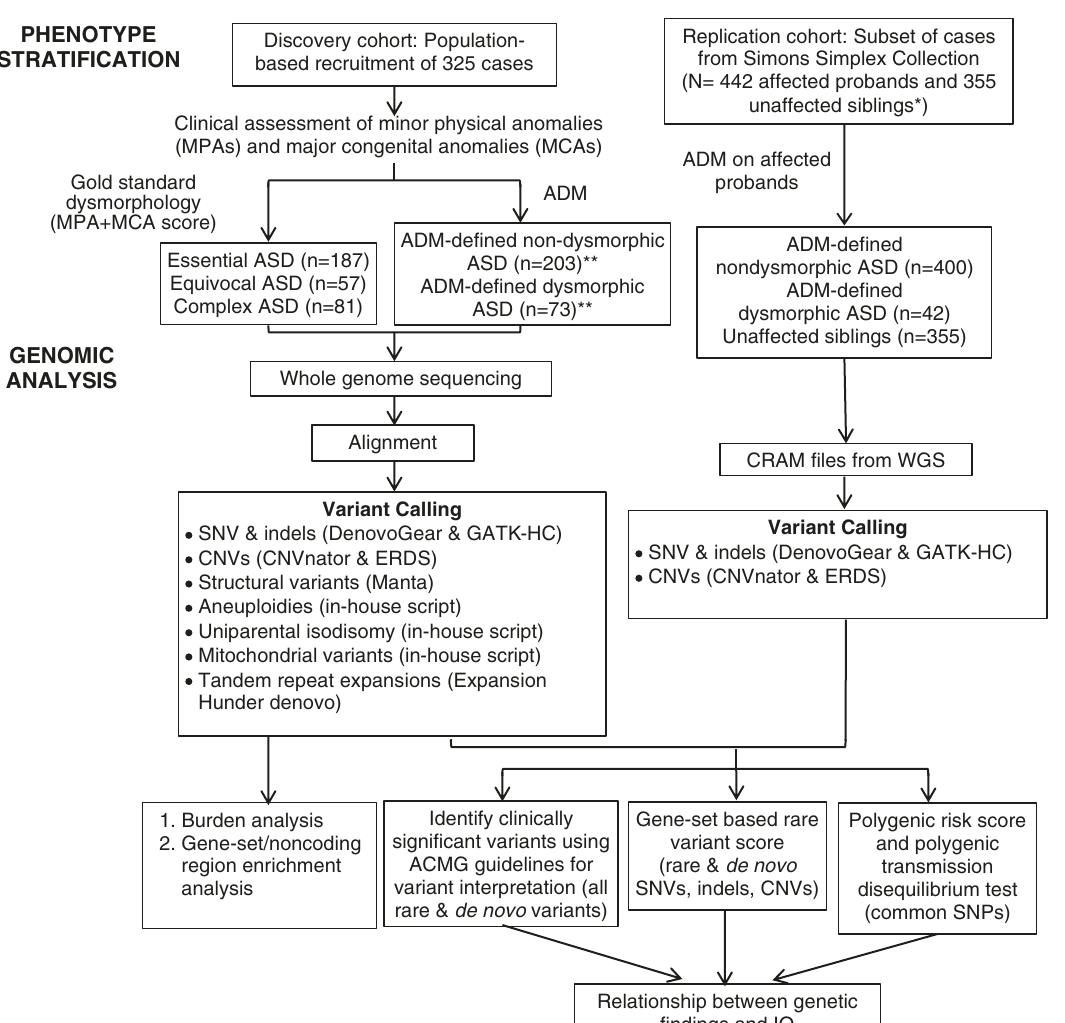
Fig. 1 | Project work fl ow. Summary of phenotype strati fi cation, whole-genome sequencing work fl ow, and genomic analyses performed in this study. ASD autism spectrum disorder, ADM autism dysmorphology measure, CNVs copy-number variants, SNVs single-nucleotide variants, indels insertions and deletions, ERDS estimation by read depth with single-nucleotide variants, GATK-HC Genome Ana- lysis Toolkit-Haplotype Caller, SNPs single-nucleotide polymorphisms, ACMG American College of Medical Genetics and Genomics, IQ intelligence quotient. *Unaffected siblings were used for GRVS and PRS analyses. **Excluding samples with false negative ADM-de fi ned nondysmorphic ASD. We also included only samples sequenced on Illumina platforms to be consistent with the replication